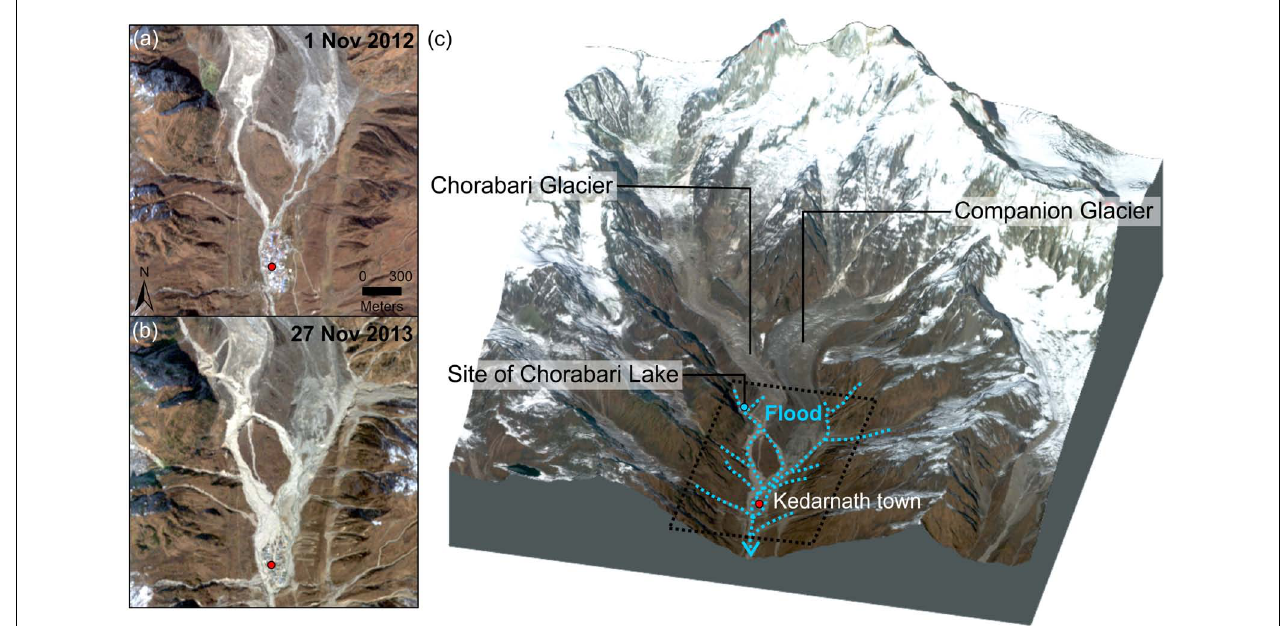
FIGURE 8 | Aerial view of Kedarnath town with (a) pre and (b) post-event RapidEye imagery from November 1, 2012 and November 13, 2013 (Planet Team, 2018). (c) Shows provides a broader view of the source areas, location of the Chorabari Lake, and direction of flooding associated with the Kedarnath debris flow